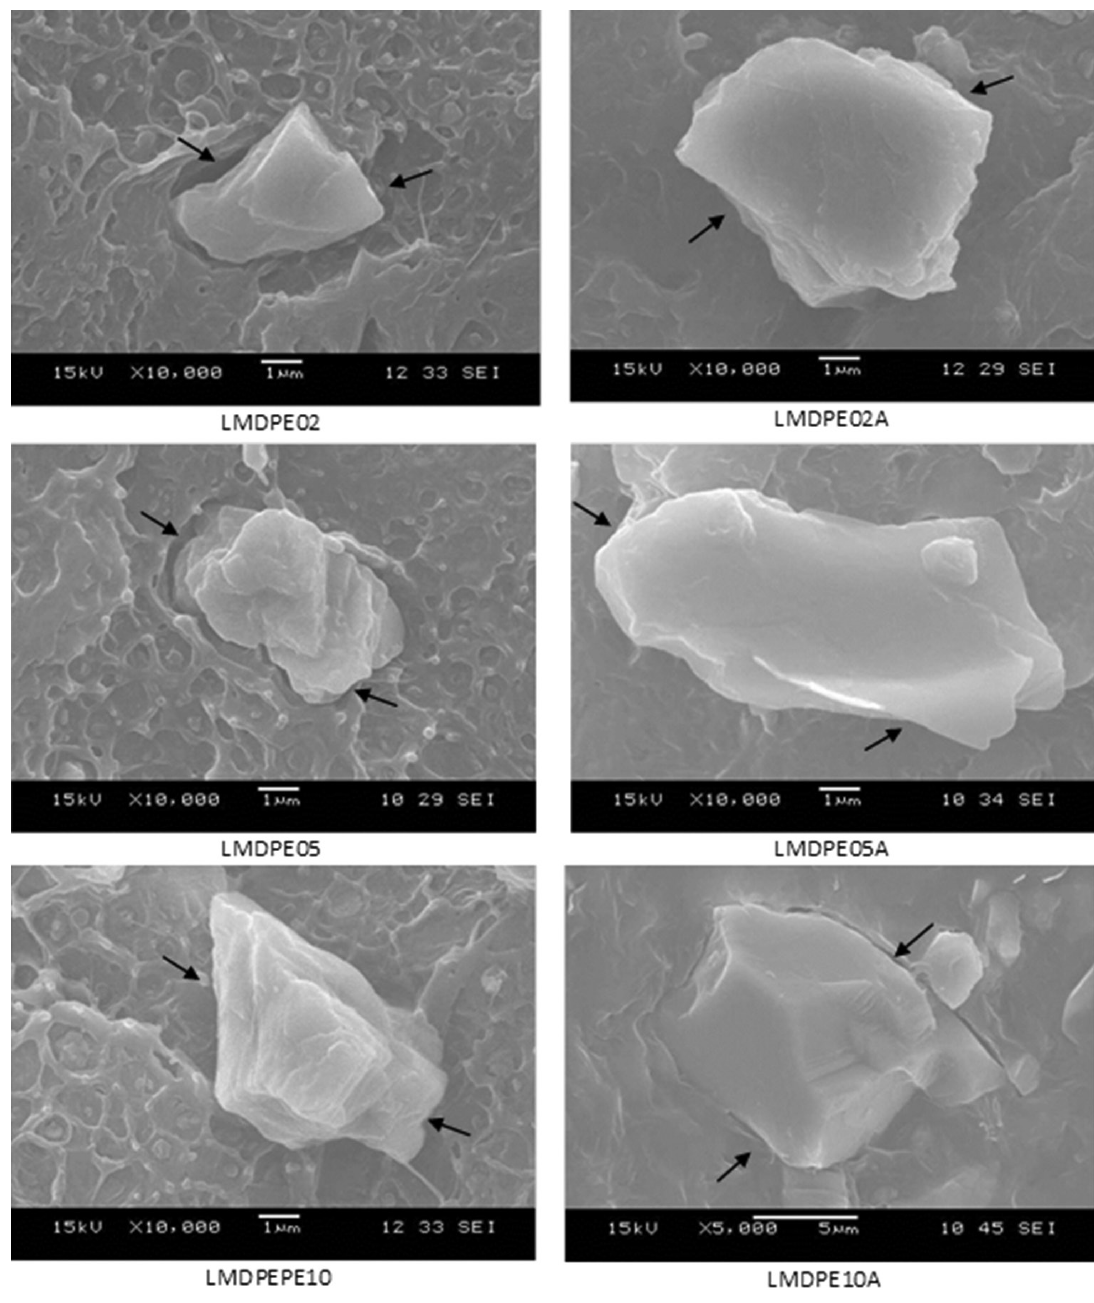
Figure 4. Cryogenic fracture micrographs of the rotomolded